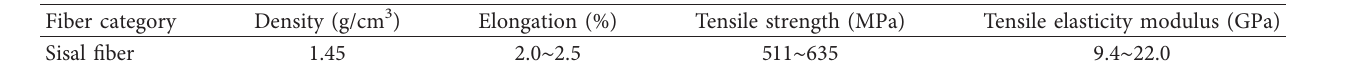
Table 2: Physical properties of the sisal fiber.